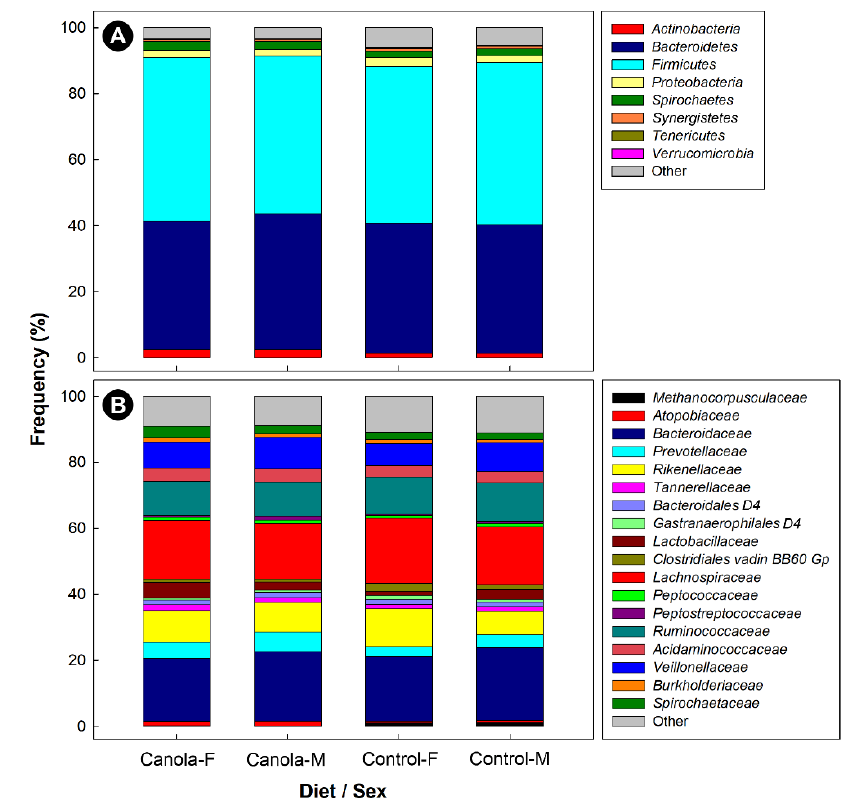
Figure 2. The relative abundance of archaea and bacterial phyla ( A ) and families ( B ) observed in the cecal digesta of 35-day-old female and male broilers fed a diet supplemented with canola meal (20%) or a control diet with ≥ 22,000 reads ( n = 43). Data were averaged for female and male birds by diet